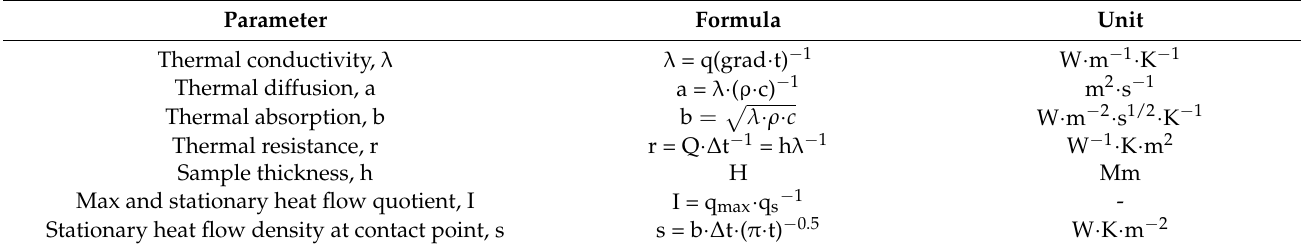
Table 4. A summary of the parameters measured on the Alambeta